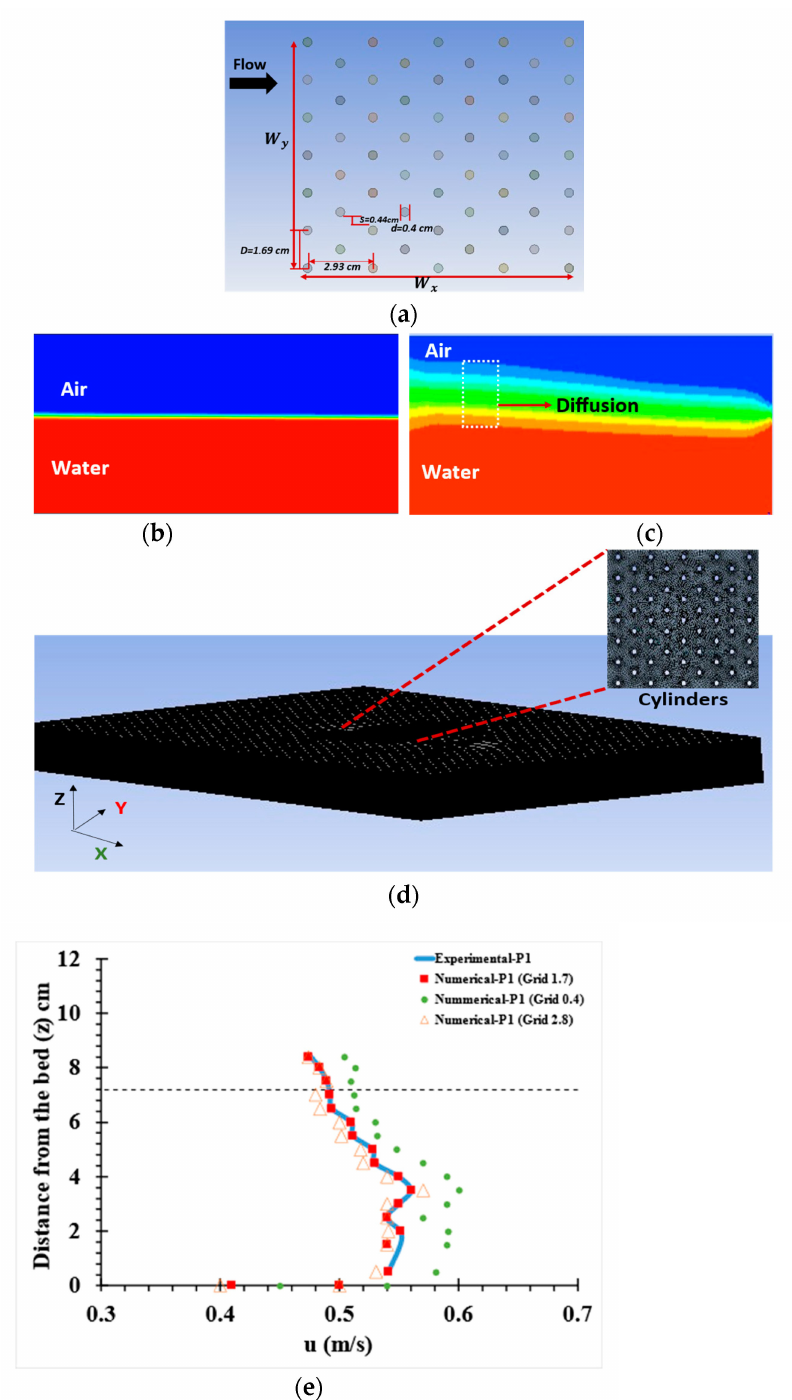
Figure 3. Preprocessing Setups. ( a ) Arrangement and spacing of cylinders: Comparison of Meshing techniques: ( b ) Multizone meshing ( c ) Tetrahedral meshing. ( d ) Mesh domain ( e ) Grid indepen- dency